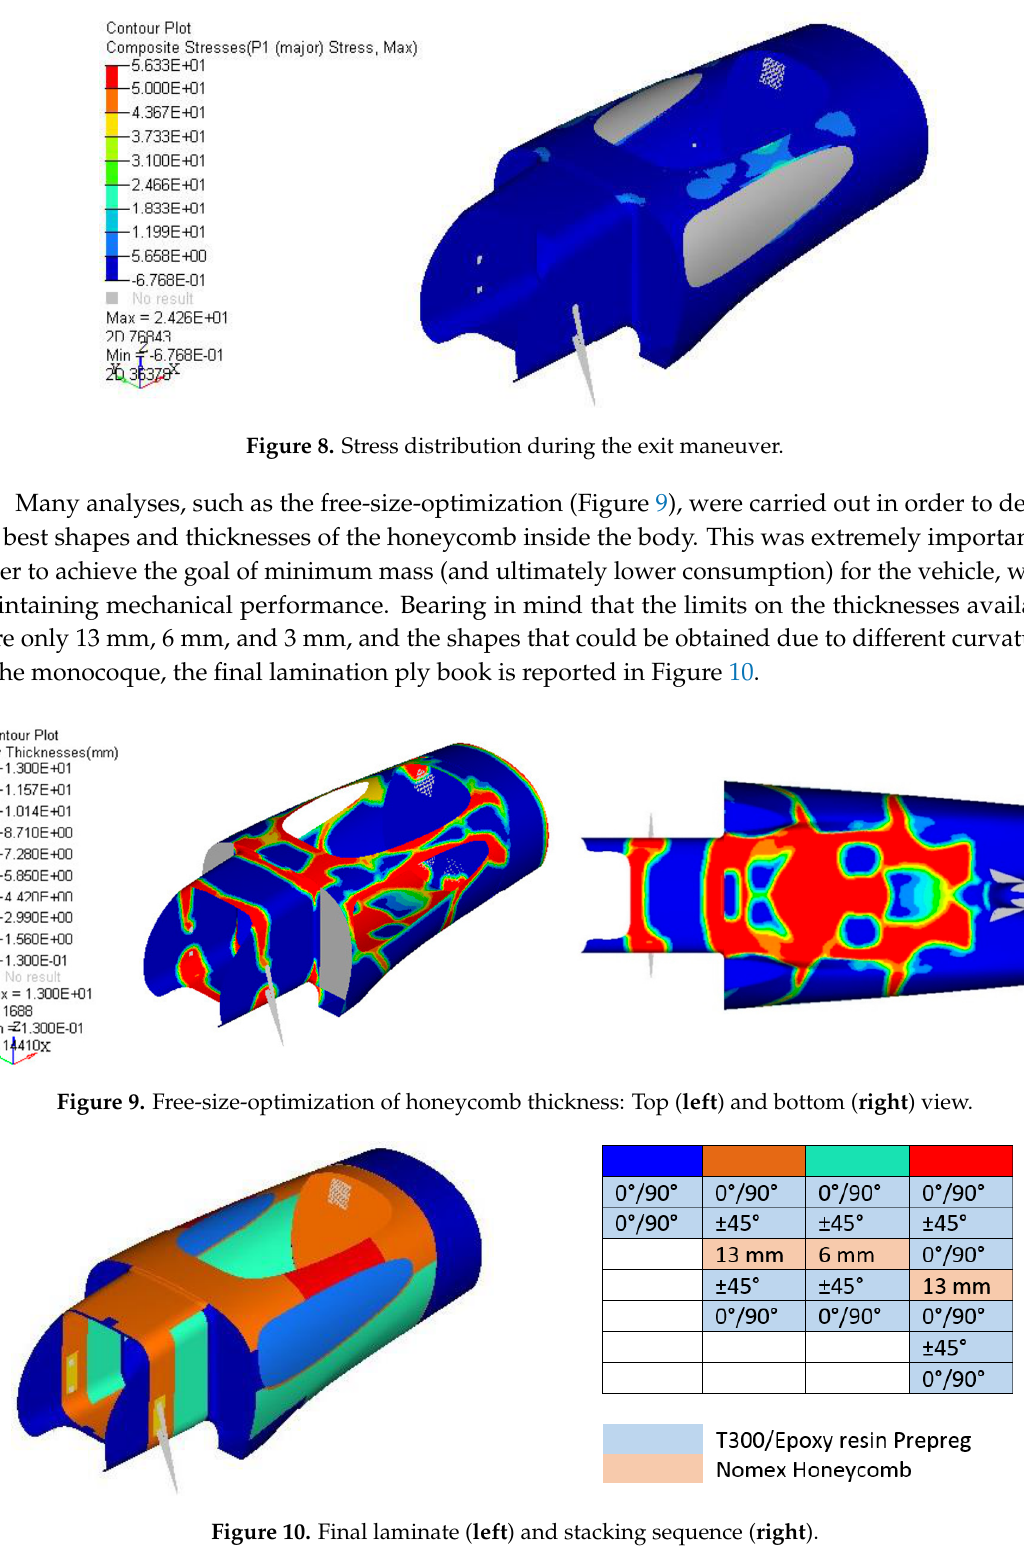
Figure 10. Final laminate ( left ) and stacking sequence ( right ).